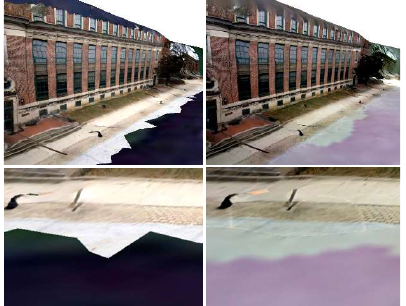
Figure 11. Seamless texture fusion with (right column) and without fusion (left column)